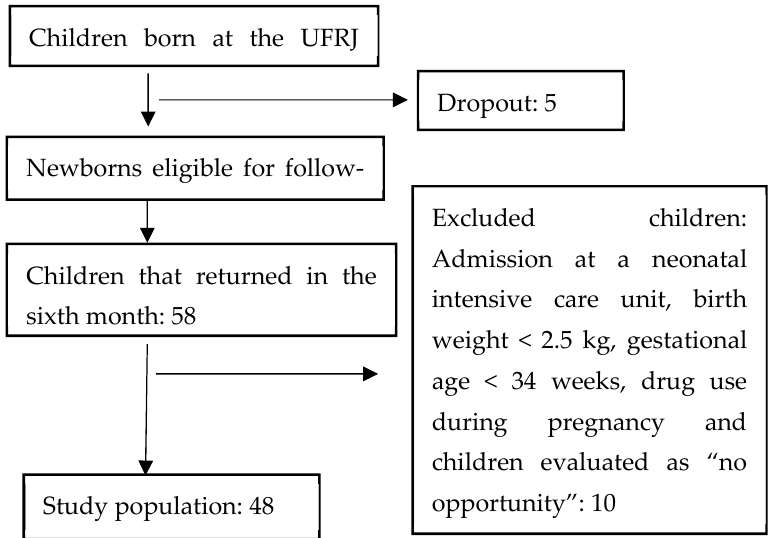
Figure 1. Selection process of the study population.